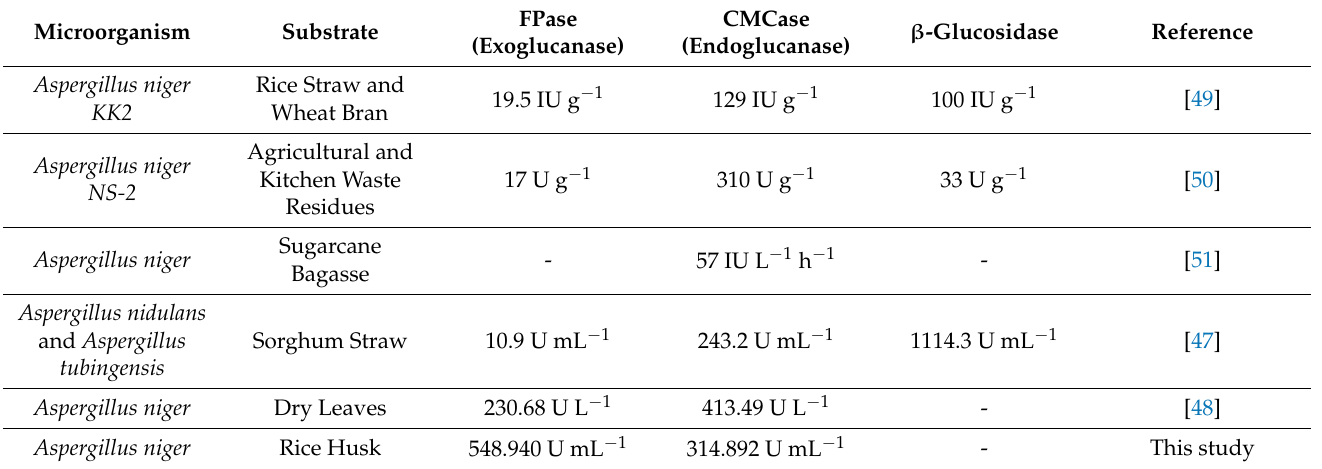
Table 3. Comparison of the activity of crude cellulase enzymes of Aspergillus species.